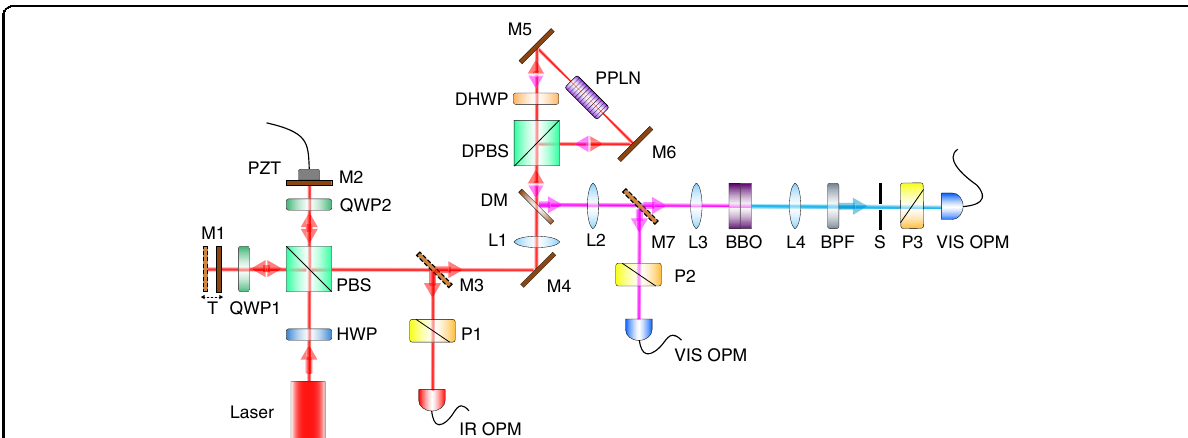
Fig. 2 Experimental setup schematic. HWP half-wave plate, QWP quarter-wave plate, DHWP 1560 nm/780 nm dichroic HWP, PBS polarizing beam splitter, DPBS dichroic PBS, M silver-coated mirror, T translation stage, PZT piezoelectric transducer, DM dichroic mirror, BPF 390 – 10 nm band-pass fi lter, PPLN periodically poled lithium niobate crystal, BBO β -barium borate crystal, S small hole, P polarizer, IR OPM infrared optical power meter, VIS OPM visible optical power meter, L lens, lenses L1 and L3 are used for focusing and L2 and L4 are used for collimation, and the focal lengths of L1 – L4 are 200 mm, 200 mm, 50 mm, and 100 mm, respectively